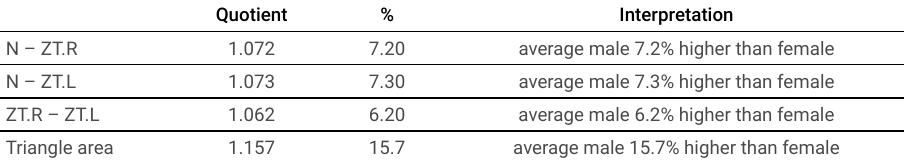
Table 3. Quotient between male and female average Quotient % Interpretation